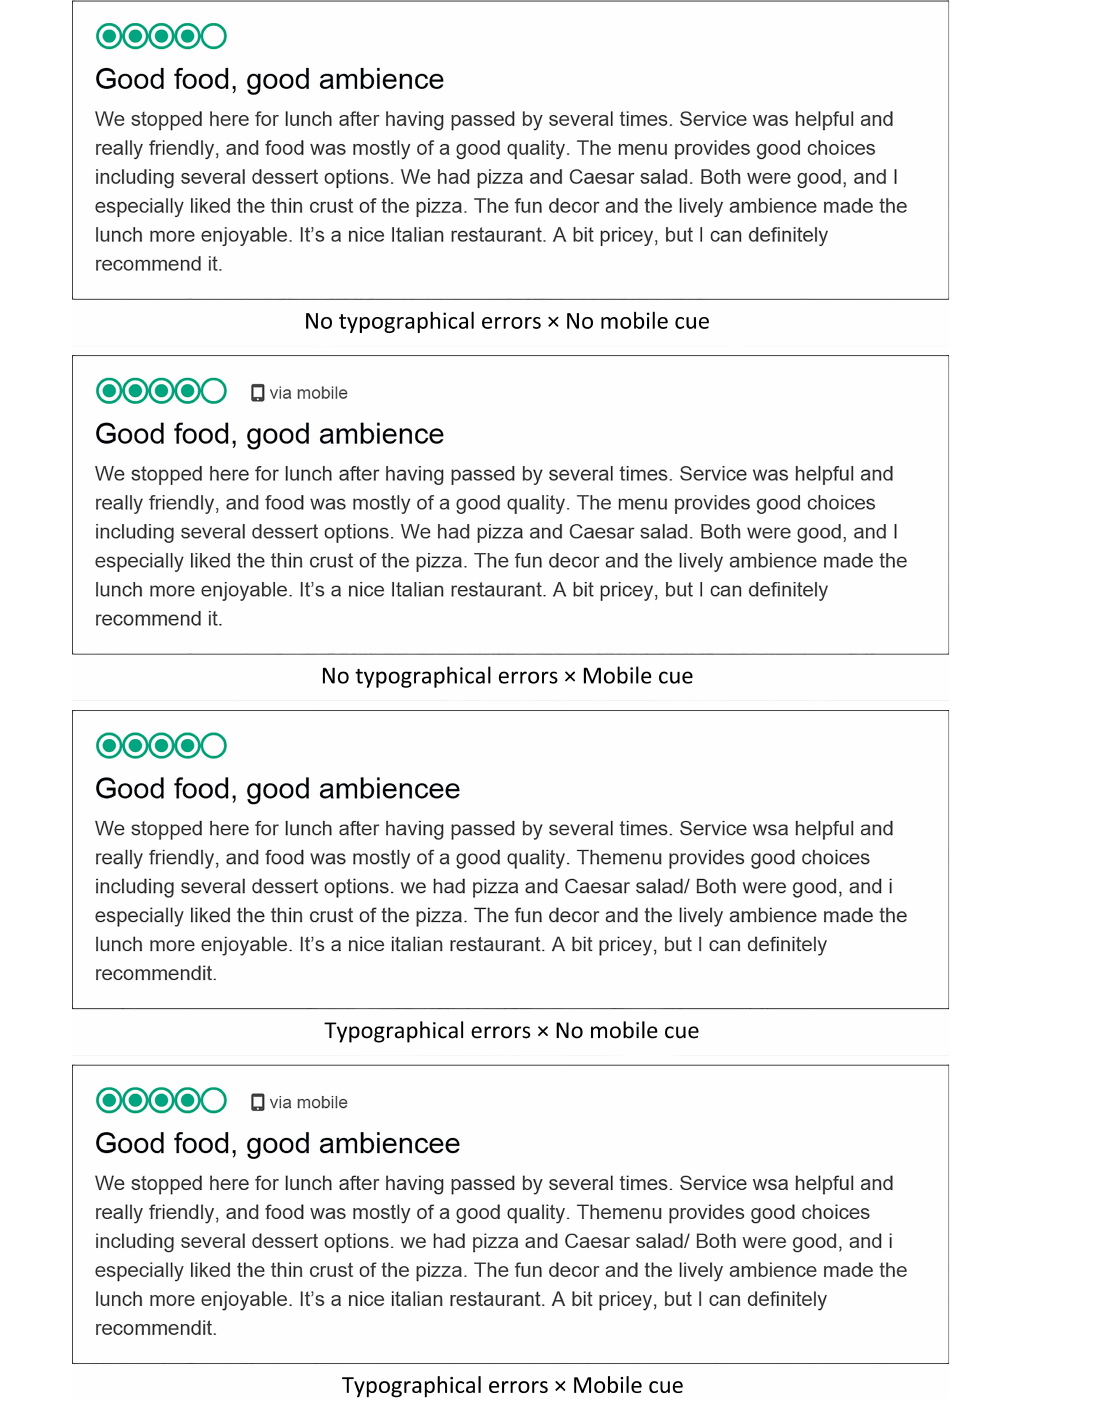
information usefulness and further information adoption (Erkan and Evans, 2016). The participants were asked to indicate their level of agreement with three statements about restaurant reviews